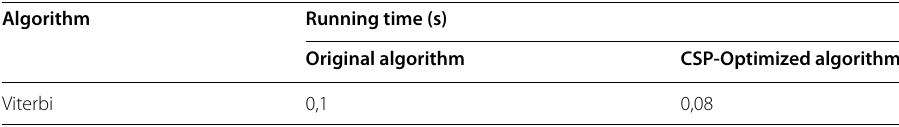
Table 4 Running time comparison of Viterbi algorithm Algorithm